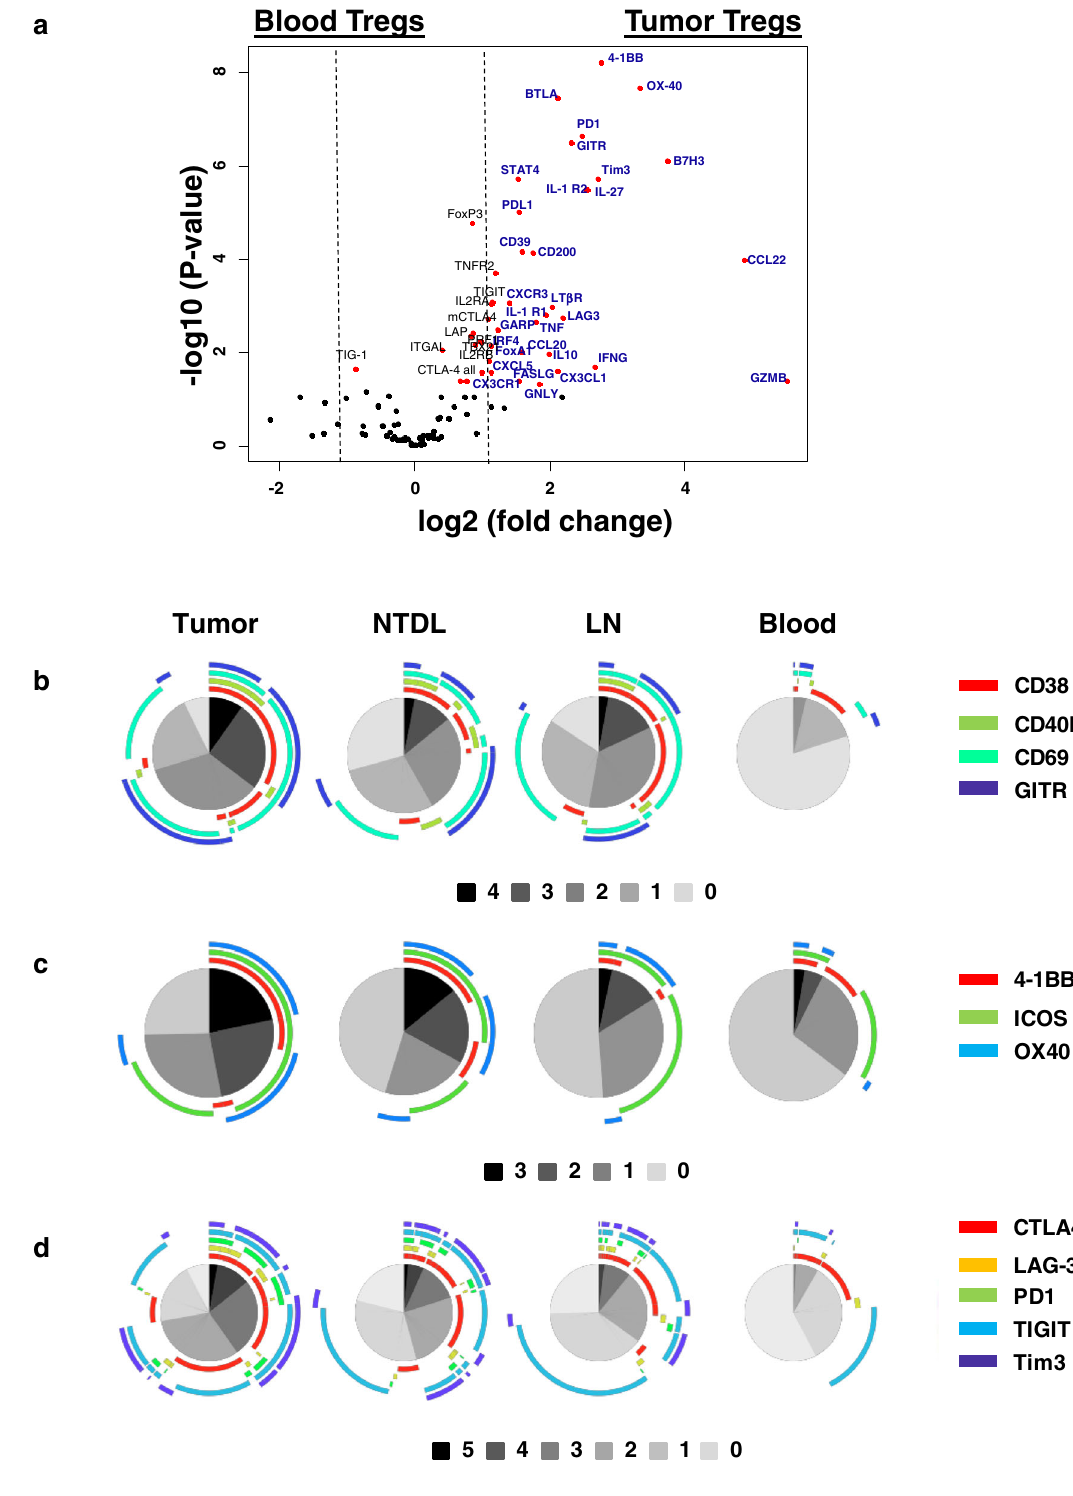
Selective molecular and protein patterns of intra-tumoral Tregs versus CD4 + Tconv in TLS and non-TLS areas . The speci fi c differentiation stage of Tregs observed in TLS versus non- TLS led us to investigate their activation and ICP status at the molecular ( n = 169) and protein ( n = 14) level, and to compare their phenotype to the CD4 + Tconv cells. Along with the FoxP3, IL2R α , and IL2R β , TLS and non-TLS Tregs signi fi cantly over- expressed many genes in comparison to the TLS and non-TLS